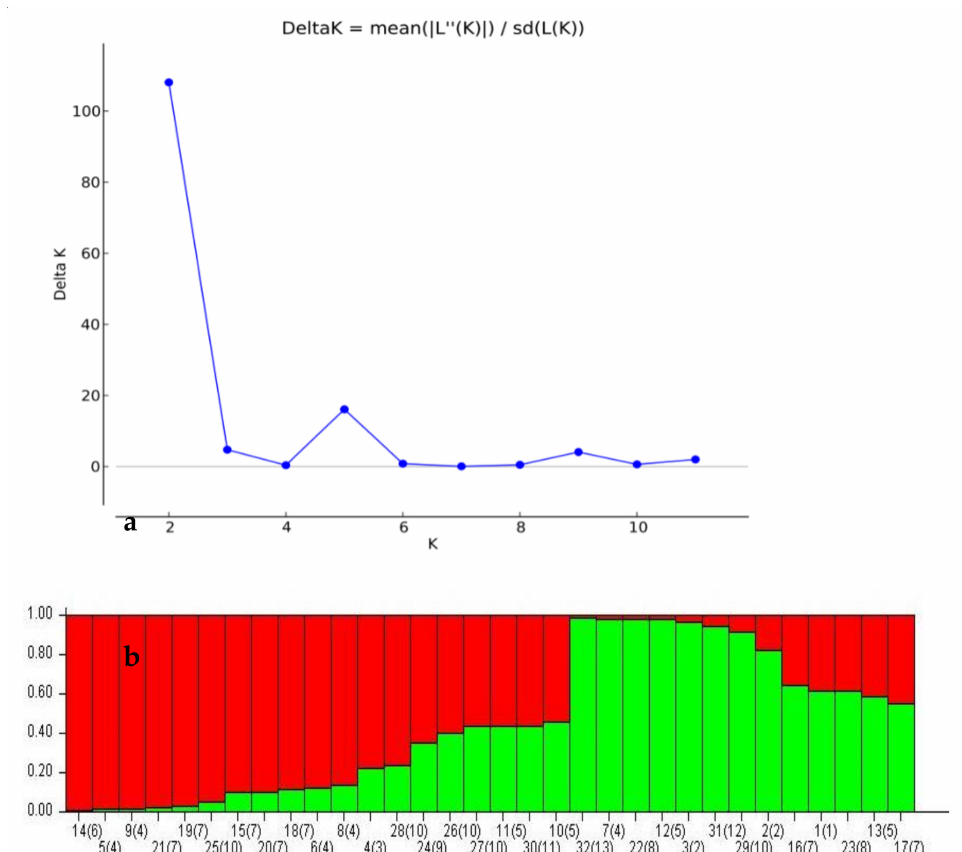
Figure 5. ( a ) ∆ K values for each number of subpopulations (K) for 32 quinoa genotypes. ( b ) Classifi- cation of 32 quinoa genotypes into two main populations using STRUCTURE 2.3.4 software. The color code indicates the distribution of the genotypes to different populations. Numbers on the y -axis show the subgroup membership, and the x -axis shows the different genotypes and population ID in